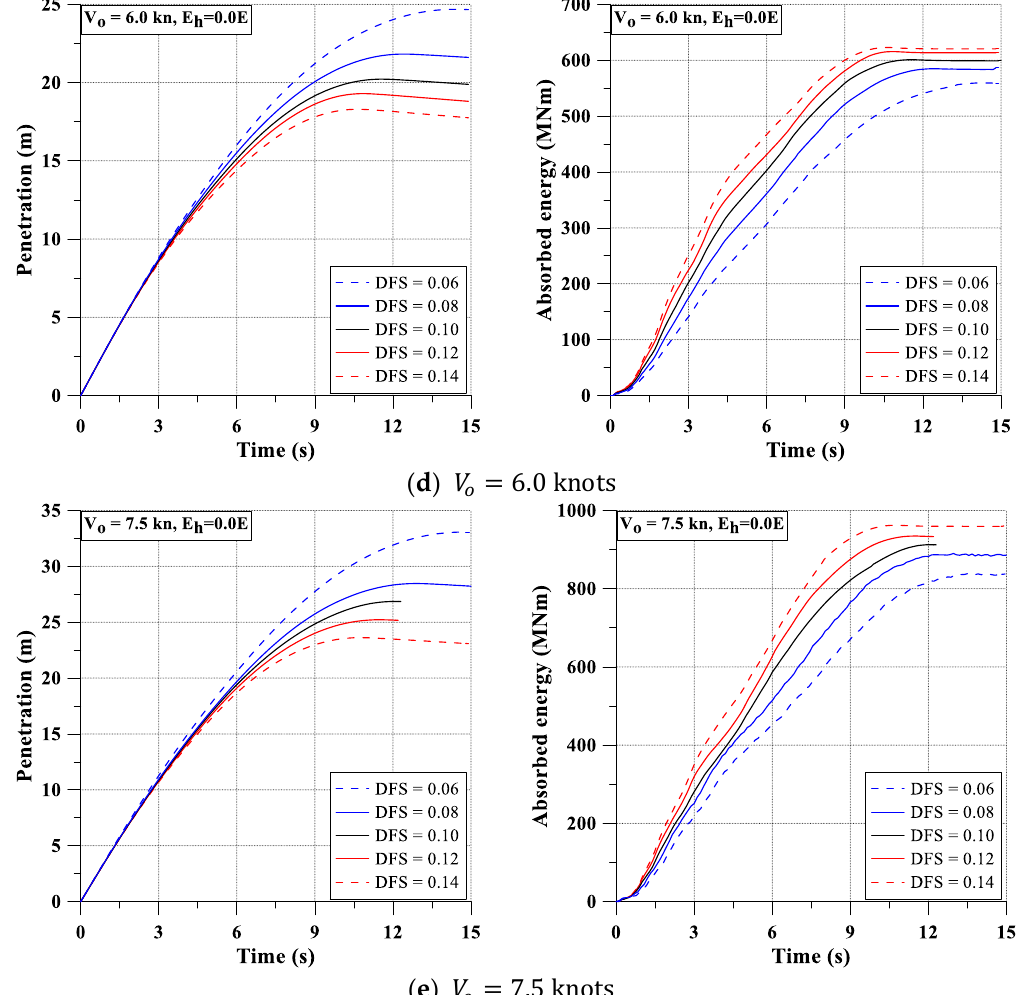
Figure 7. Effect of DFS on dynamic structural responses depending on 𝑉 𝑜 with 𝐸 ℎ = 0.0𝐸 .